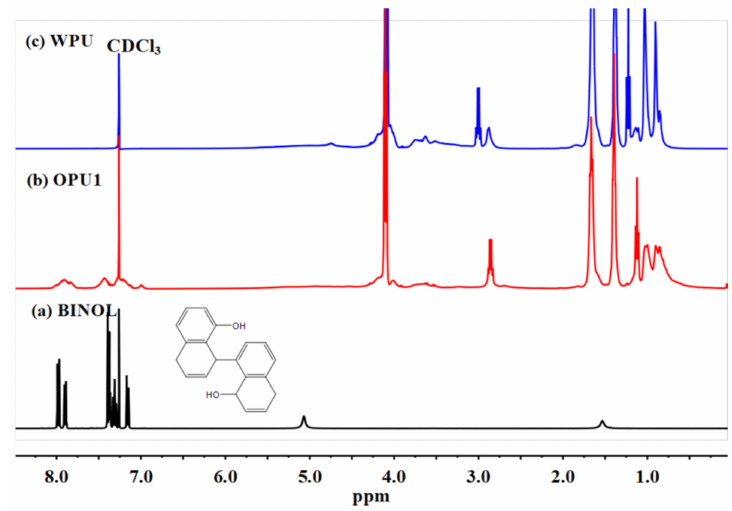
Figure 2. 1H NMR spectra of BINOL, OPU1, and WPU: ( a ) BINOL, ( b ) OPU1, ( c ) WPU.